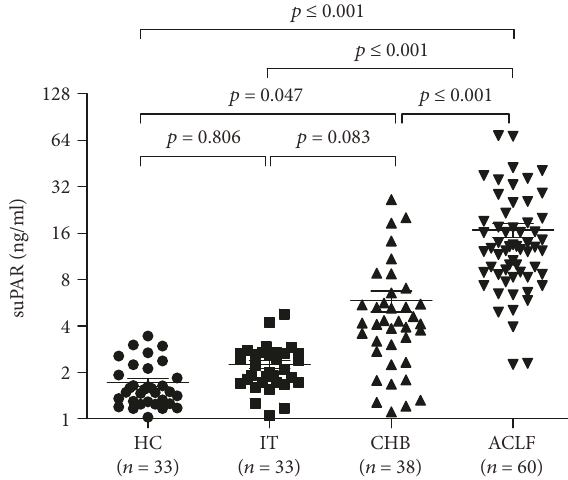
Figure 1: Serum suPAR concentration was increased in patients with hepatitis B-related acute-on-chronic liver failure. The comparison of serum suPAR concentration in the health controls (HC), HBV carriers in immune tolerance (IT), chronic hepatitis B (CHB), and hepatitis B-related acute-on-chronic liver failure (HB- ACLF) groups. Values are expressed as median ± interquartile